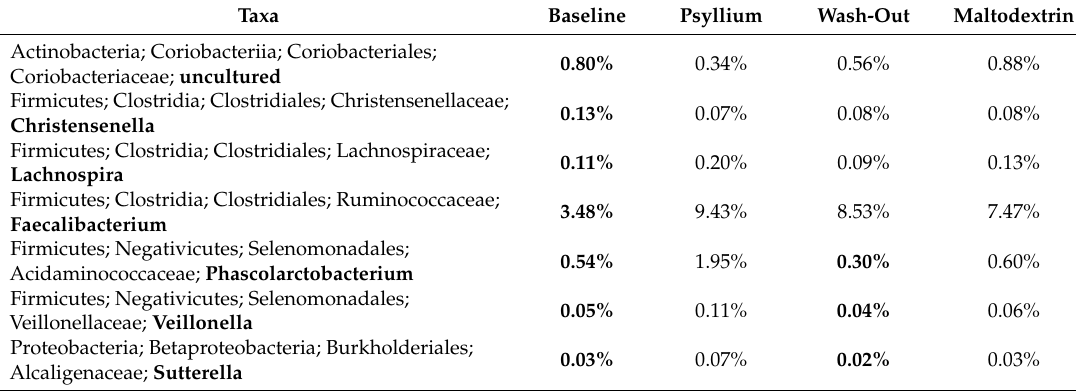
Table 3. Bacterial taxa affected by the psyllium treatment of constipated patients. Entries represent average relative abundance. Those time points with statistically significantly different bacterial abundance from the psyllium supplementation are indicated in bold ( q- values below 0.05).